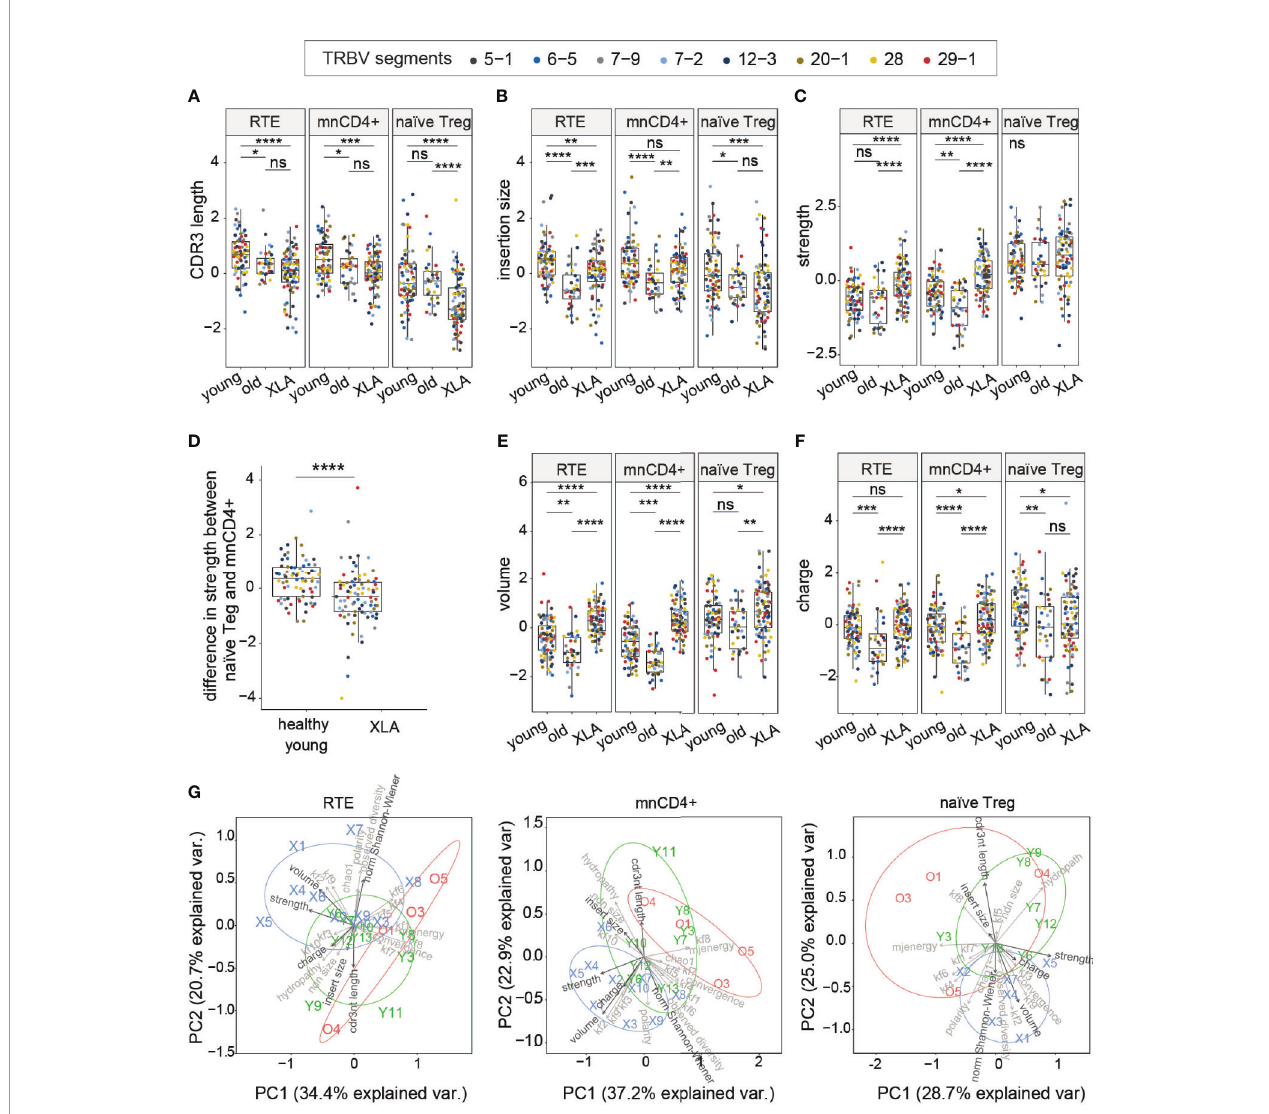
FIGURE 4 | CDR3 characteristics of TCR b repertoires of naïve CD4 + subsets in healthy donors and XLA patients. (A) CDR3 b length, (B) added nucleotides in CDR3 b for the most abundant V segments for full clonotype datasets, (C) estimated average number of strongly-binding amino acids in the central region of CDR3 for nCD4 + populations in XLA and healthy donors. (D) The difference in CDR3 b interaction strength between naïve T reg and mnCD4 + cell repertoires. (E) Estimated average number of bulky amino acids, and (F) charged amino acids in the central region of CDR3 for nCD4 + populations from XLA and healthy young or old donors. The number of healthy young, old and XLA donors was 9, 4 and 10 respectively. For panels (A – F) , statistical signi fi cance of median differences was evaluated by Dunn test controlled using the Benjamini-Hochberg adjustment. Only segments with a suf fi cient number of UMIs were included. To exclude potential dependence of features from the V segment, all features within the same cell type and the same V segment were turned to Z-scores. Differences between groups were assessed using the Kruskal-Wallis test followed by Dunn test, with the Benjamini-Hochberg stepwise adjustment. *p < 0.05, **p < 0.01, ***p < 0.001. (G) Principal component analysis (PCA) of nCD4 + subsets based on 23 TCR repertoire characteristics. PC1 is the fi rst principal component, PC2 is the second. Each dot represents an individual TCR repertoire sample. Arrows in bold show properties from A – F and normalized Shannon-Wiener index. NS, non signi fi